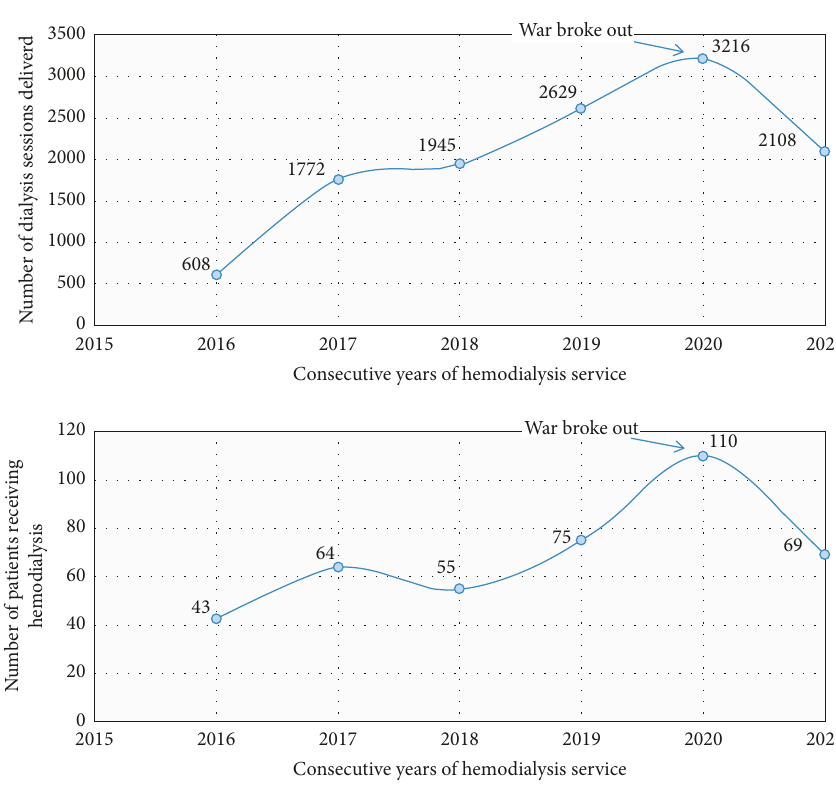
Figure 3: Data from Ayder Hospital haemodialysis centre registry displaying number of haemodialysis sessions delivered (upper) and number of patients enrolled to haemodialysis centre (lower) in each consecutive year from 2016 to